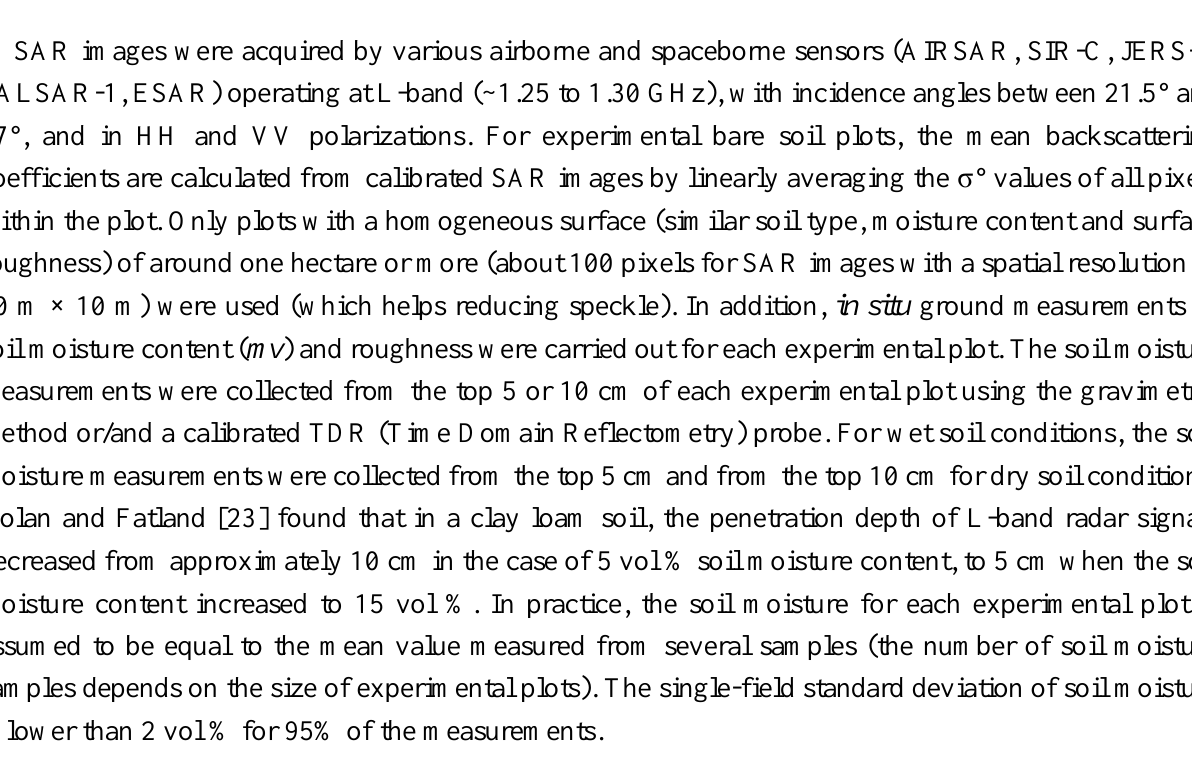
Figure 1. Location of various study sites. “1”: Orgeval; “2”: Saint Lys; “3”: Matera; “4”: Alzette; “5”: Dijle; “6”: Zwalm; “7”: Demmin; “8”: